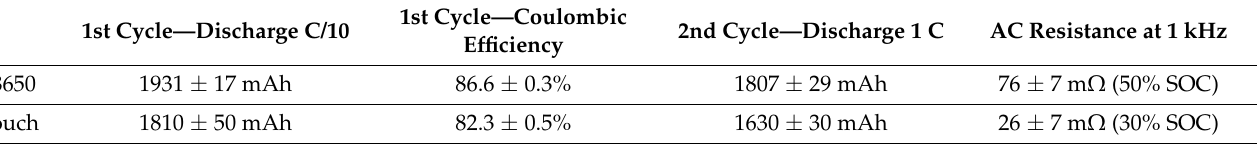
Table 1. Average first cycle discharge capacity (at C/10) and coulombic efficiency, second cycle discharge capacity (at 1 C), and AC resistance of the pouch and the 18650 cylindrical cells assembled.